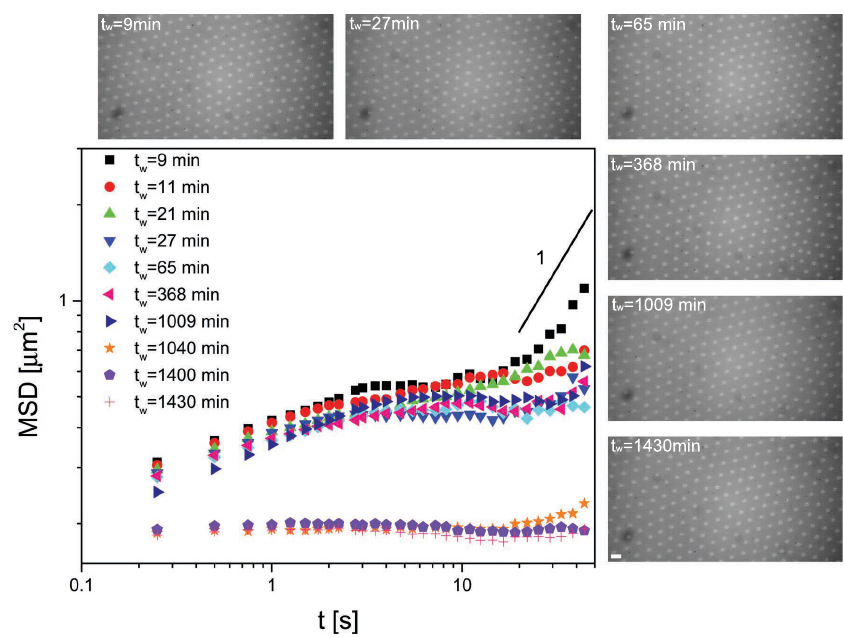
Figure 2. Mean squared displacements (MSD) versus time for 2.8 µ m polystyrene (PS) particles at the water–decane interface as a function of residence time at the interface t w . A solid line with slope 1 representative of freely diffusive motion is included for comparison. The micrographs show the interface microstructure at various waiting times. The scale bar is 10 µ m.